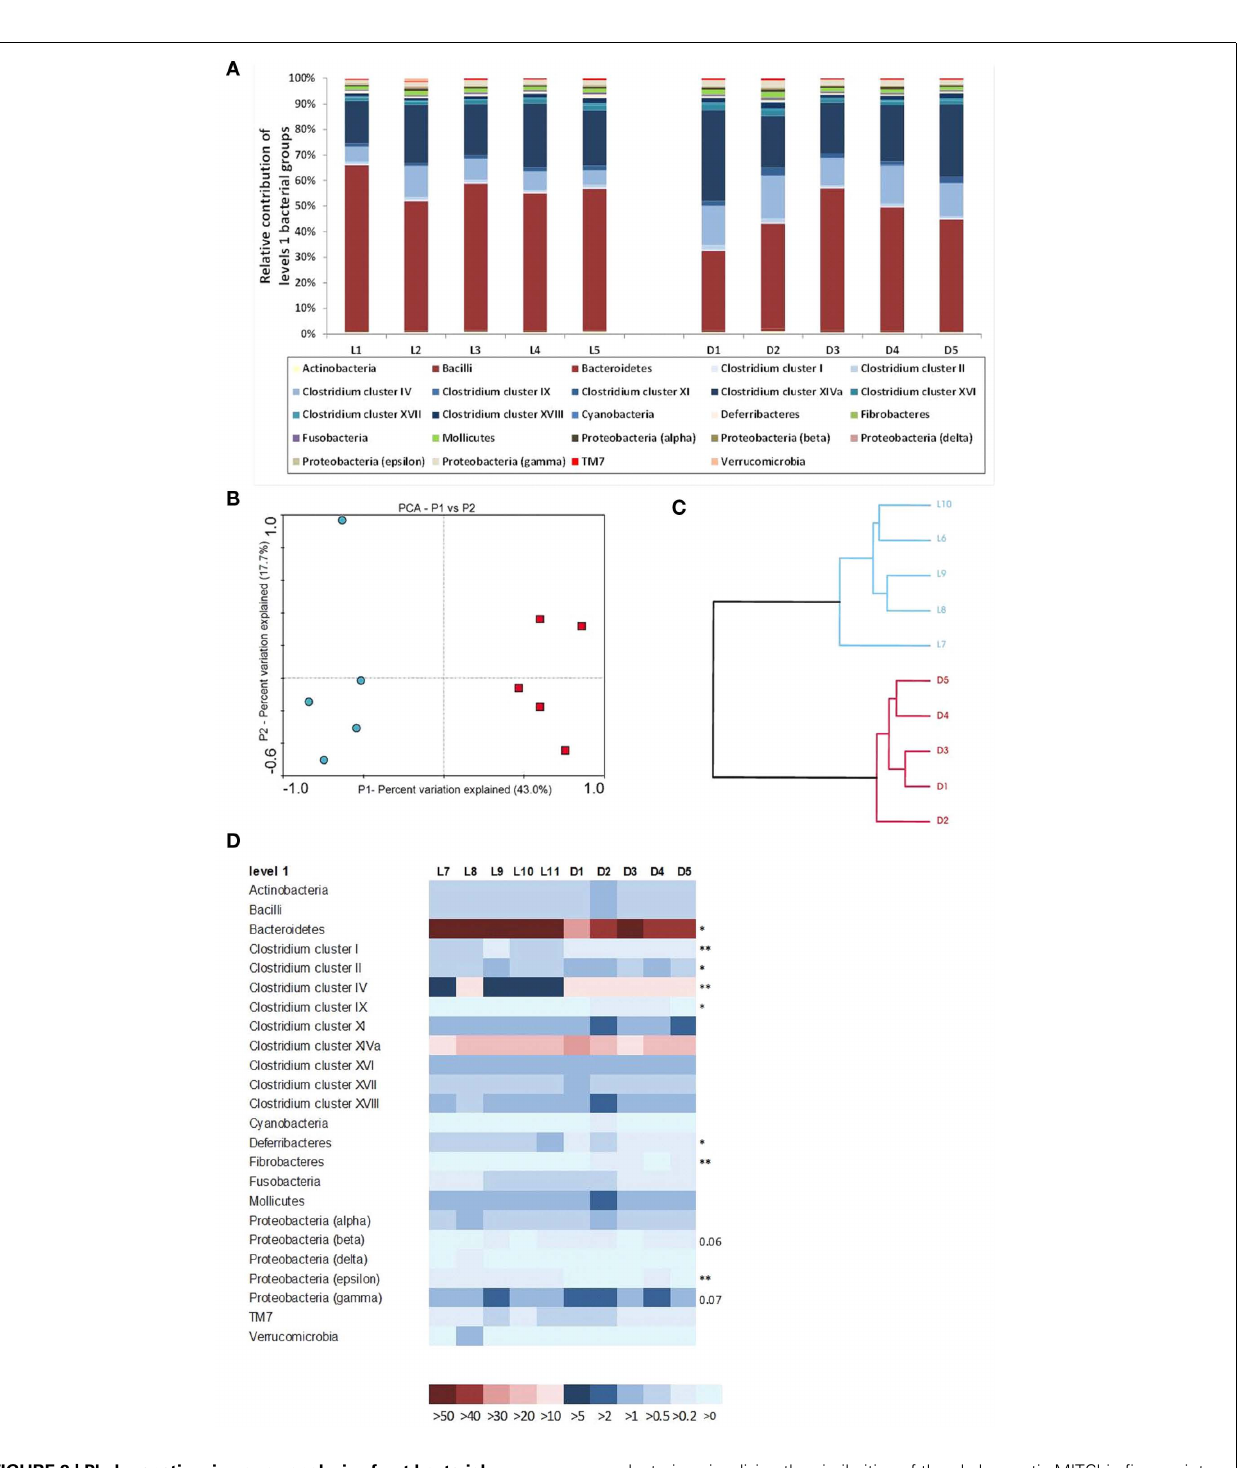
FIGURE 2 | Phylogenetic microarray analysis of gut bacterial communities from obese diabetic mice or lean mice. (A) Percentages of each community contributed by the indicated level 1 bacterial groups. (B) PCoA analysis based on MITChip phylogenetic fingerprints of the gut microbiota from the cecal contents of db / db and lean mice. (C) Hierarchical